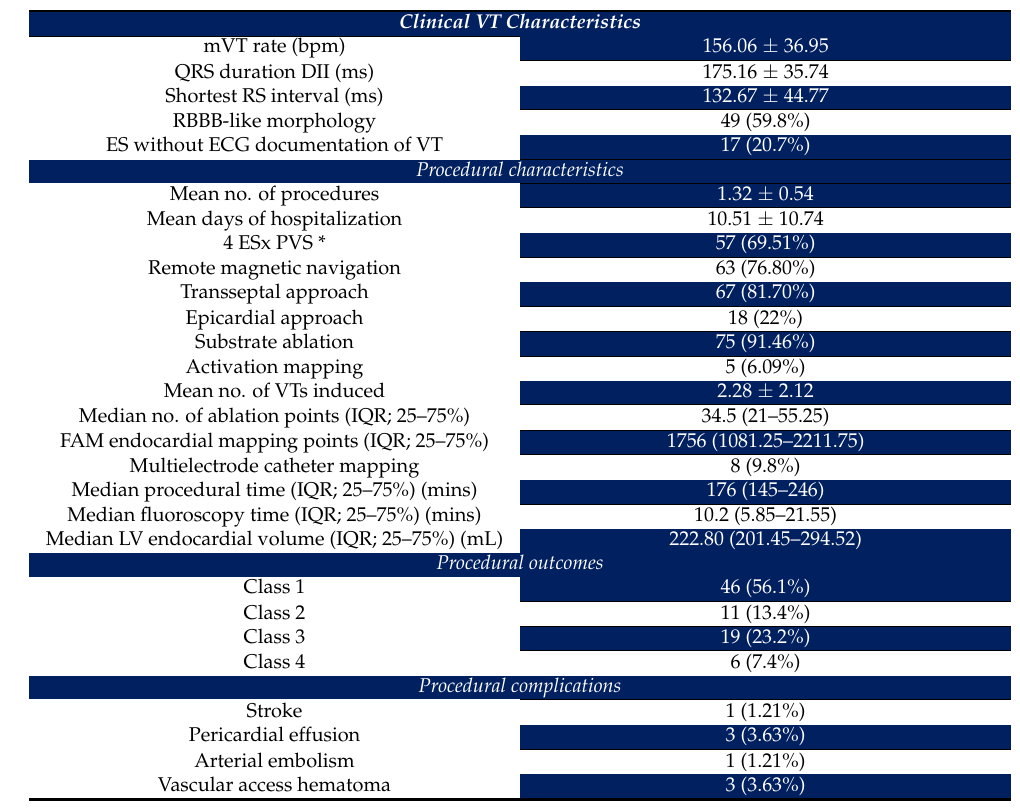
Table 2. Clinical VT characteristics, procedural characteristics, outcomes, and complications. VT = ventricular tachycardia, RBBB = right bundle branch block, ES = electrical storm, no. = number, IQR = interquartile range (25–75), FAM = fast anatomical mapping, LV = left ventricle. * Out of the 25 subjects with no PVS-4 Esx testing, 4 subjects had a Class 4 outcome and 11 subjects had a Class 3 outcome during initial 3-ESx PVS; thus, 4-ESx PVS was not subsequently performed; the remaining 10 subjects with no 4-ESx PVS (nine subjects with Class 1 outcome and one with Class 2 outcome) were assigned to procedural outcomes only by 3-ESx due to frailty; 37 patients were assigned to Class 1 and 10 subjects to Class 2 by 4 ESx PVS; moreover, there were 8 Class 3 patients and 2 Class 4 patients who were discovered at 4-ESx